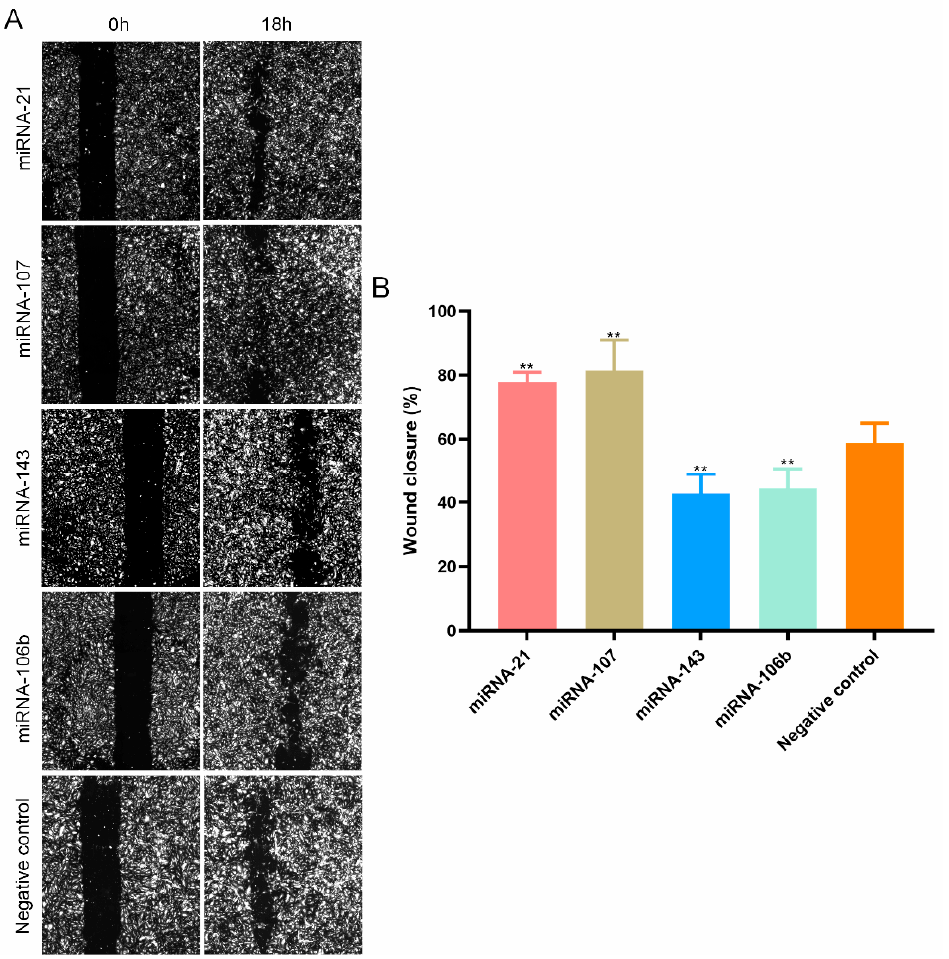
Figure 5. The overlapping four miRNAs influence the HUVECs migration. ( A ) microscopy images of HUVECs migration after transfected with the 4 miRNAs. ( B ) The wound closure (%) of HUVECs after transfected with the 4 miRNAs. ** p < 0.01. All experiments were performed independently three times.